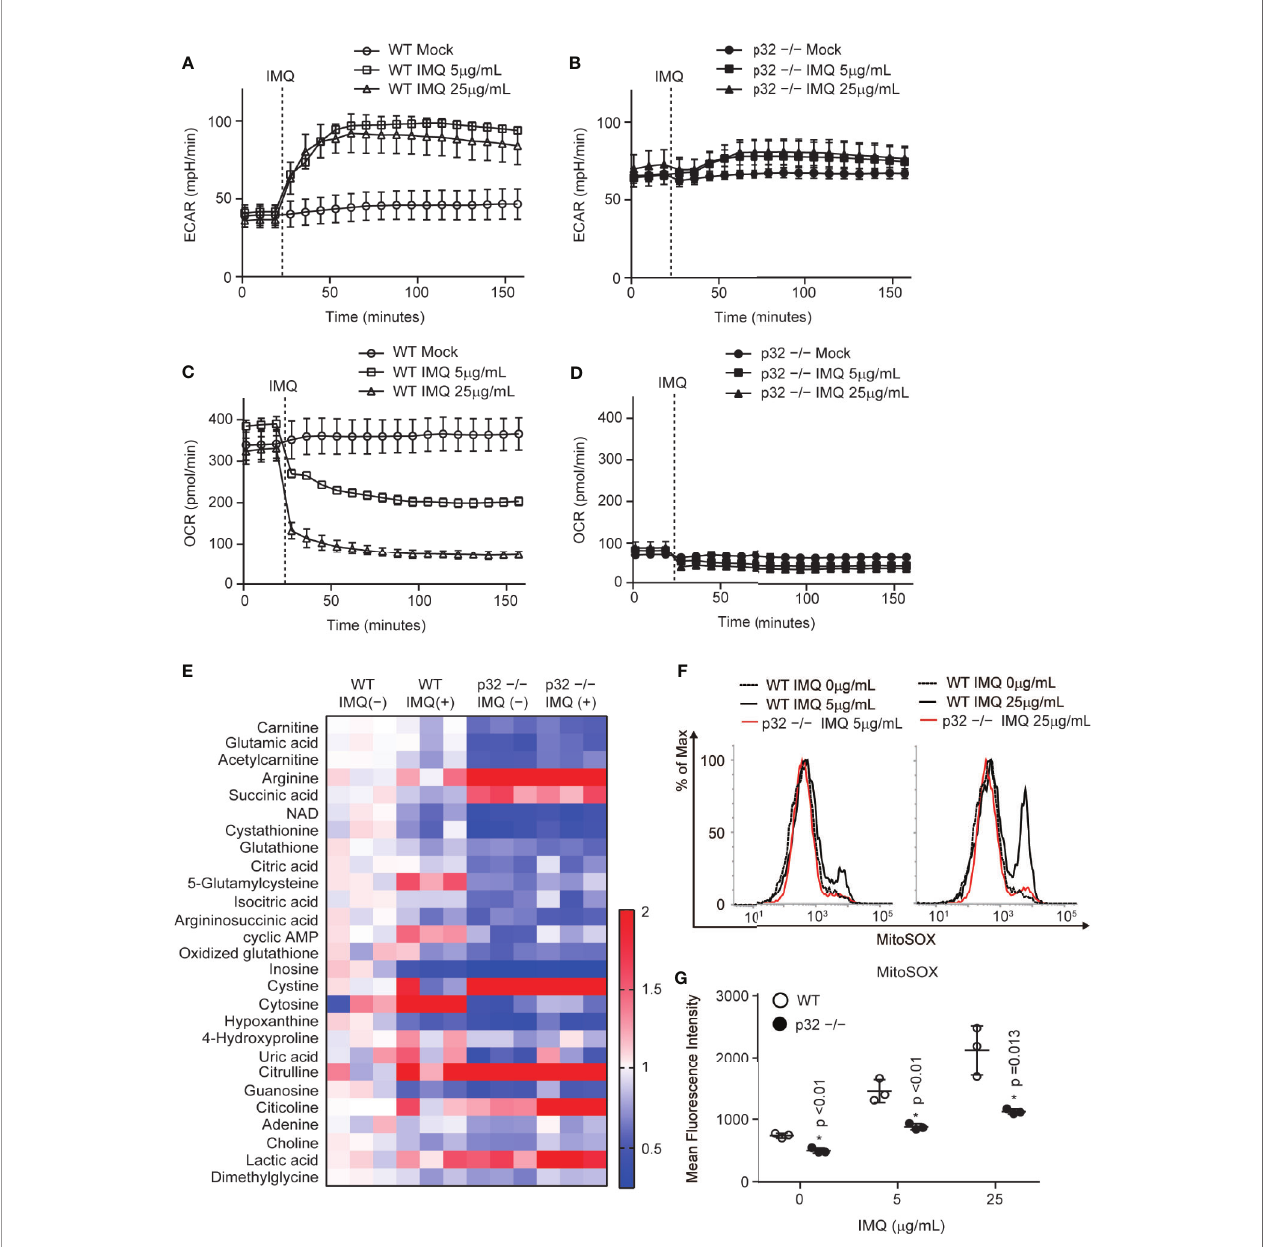
FIGURE 4 | p32/C1qbp regulates mitochondrial metabolism and ROS after IMQ stimulation. (A – D) Real-time changes in the ECAR (A, B) or OCR (C, D) in WT (A, C) and p32 − / − (B, D) DCs treated with 5 m g/mL IMQ. Vertical dotted lines indicate the initiation of treatment. Data are shown as means ± SDs of triplicate wells. (E) Comparisons of the amounts of metabolites between WT and p32 − / − BMDCs with or without IMQ stimulation. Heat map of WT and p32 − / − DC metabolites that exhibited statistically signi fi cant changes (P < 0.05). (F, G) Flow cytometry histograms (F) and quanti fi cation (G) of the expression of mitochondrial ROS (MitoSOX) in WT and p32 − / − DCs treated with 5 or 25 m g/mL IMQ. Data are shown as means ± SDs of triplicate wells. Data are representative of two (E) and three (A – D, F – G) independent